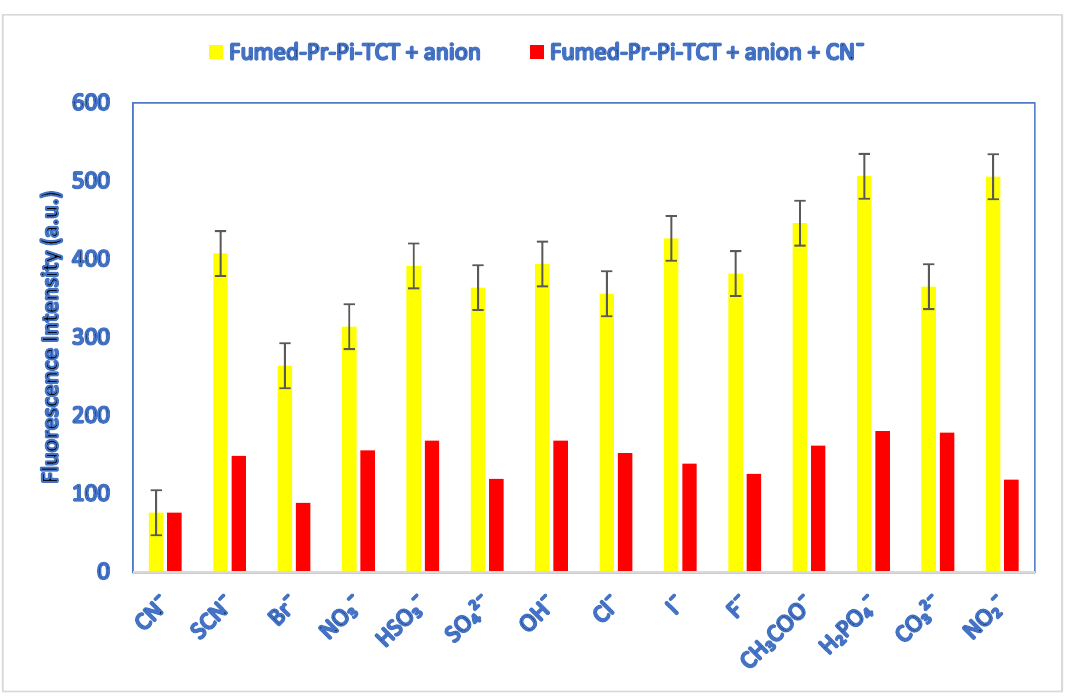
Figure 5. Selectivity of fumed-Pr–Pi-TCT (3 mL H ₂ O suspension, 0.2 g L − 1 ) for CN ⁻ (100 μ L, 1 × 10 ⁻ ² M) with equal amounts of interfering anions ( λ em = 500 nm, λ ex = 350 nm).